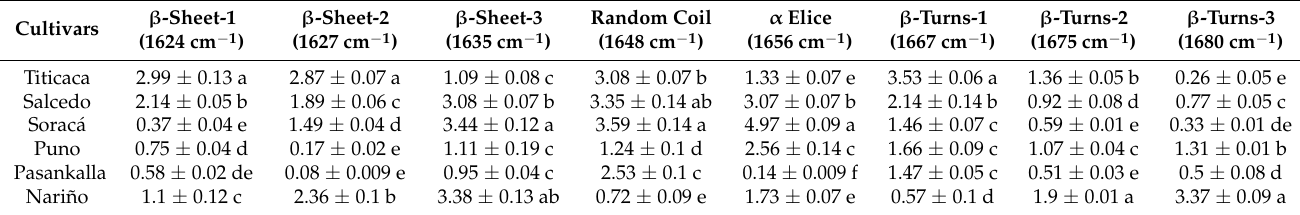
Table 3. Secondary protein structures in six Colombian quinoa